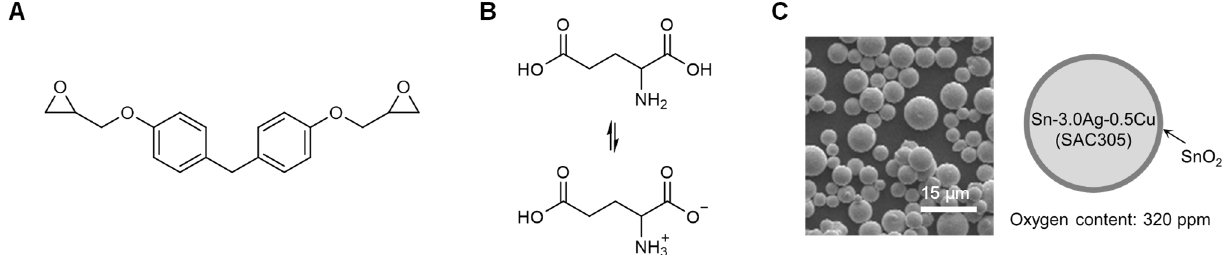
Figure 1. Materials used in the study. ( A,B ) Chemical structure of diglycidyl ether of bisphenol (DGEBF) ( A ) and Glu ( B ). ( C ) SEM image (left) and illustration (right) of SAC305 type-6 powder.